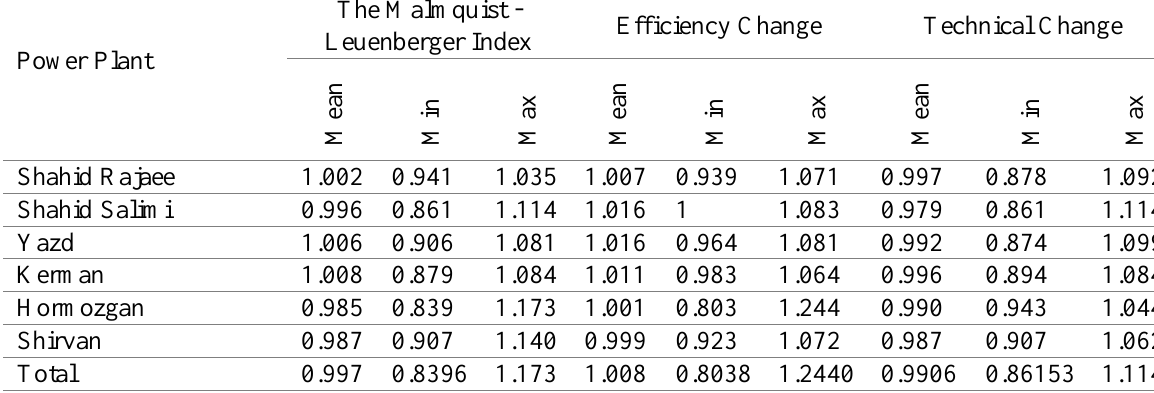
Technical Change Efficiency Change